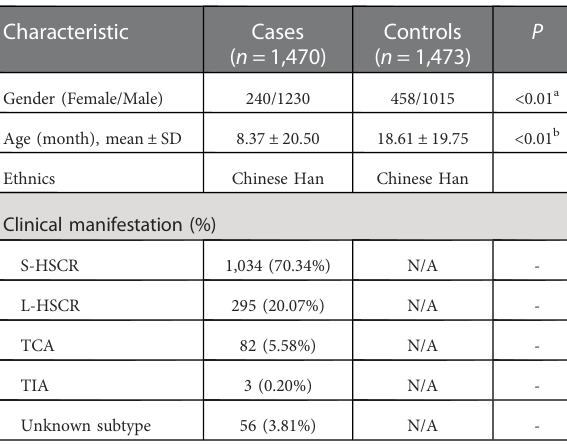
TABLE 1 Clinical characteristics of the